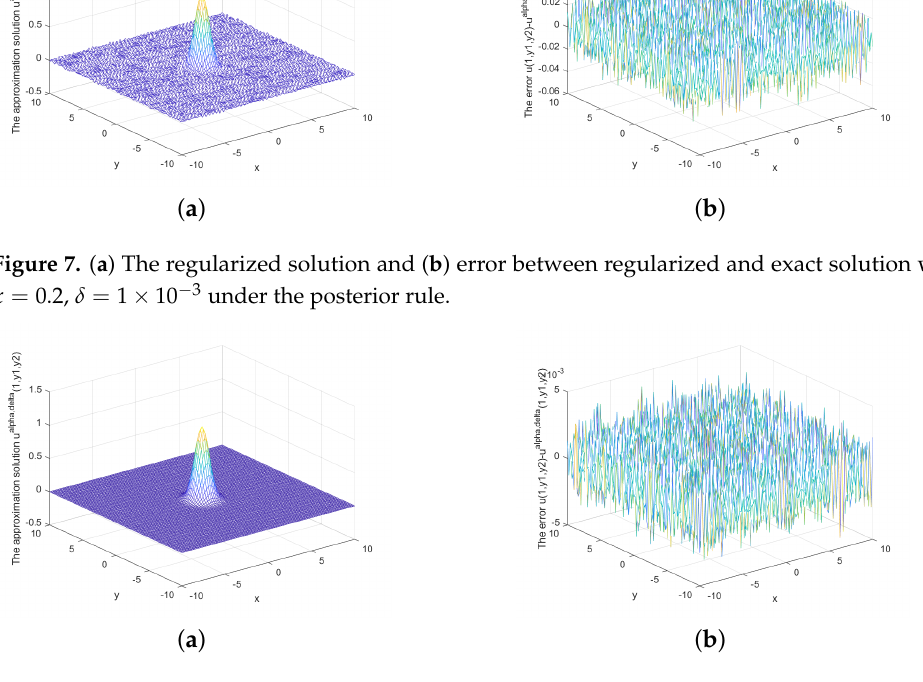
Figure 8. ( a ) The regularized solution and ( b ) error between regularized and exact solution when x = 0.2, δ = 1 × 10 − 4 under the posterior rule.